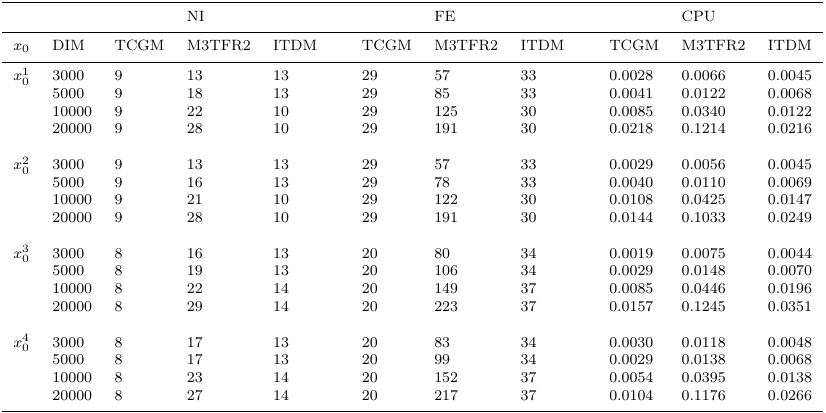
Table 1. Numerical results of Problem 1.